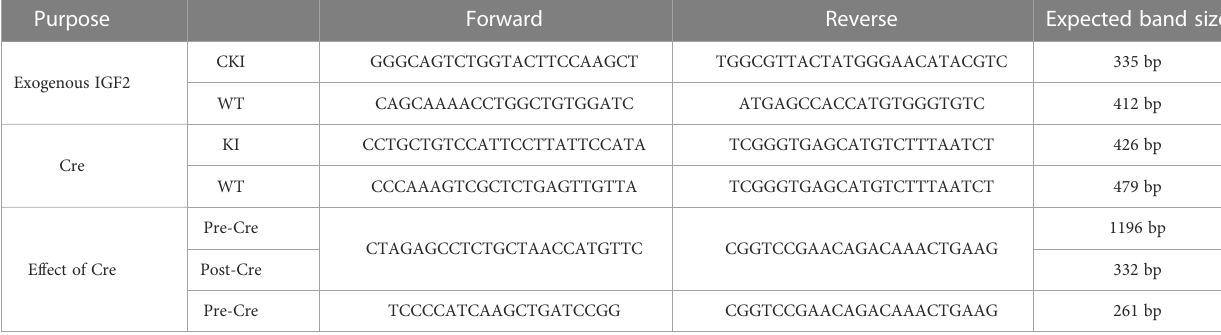
TABLE 1 Primers for gene identi fi cation in the mouse model of IGF2 gene overexpression.